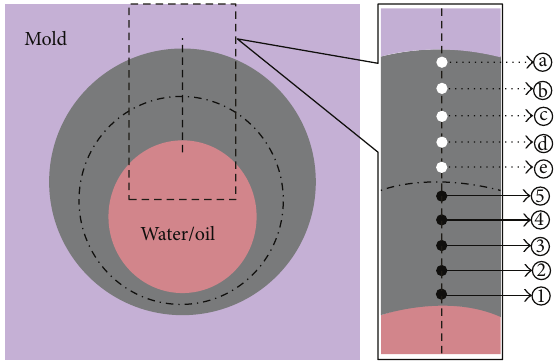
Figure 8: Set of measurement position for thickness